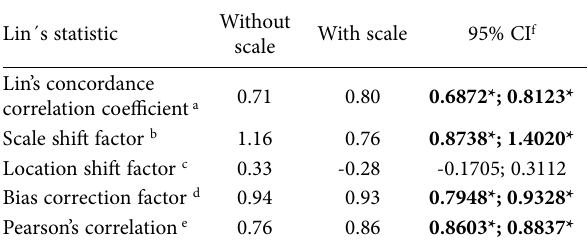
Table 3. Lin’s concordance correlation coefficients for eight evalu- ators without or with the diagrammatic disease severity scale, used to estimate rust severity on fig leaves.